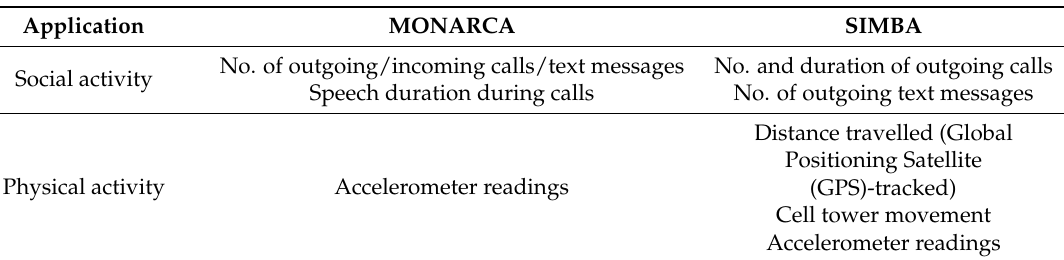
Table 3. Markers tracked by MONARCA &